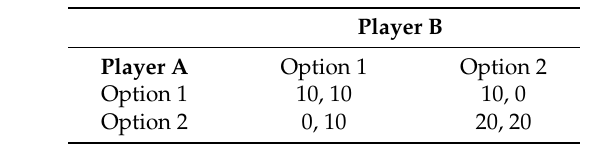
Table 1. Payoff matrix of the Stag Hunt game in the present